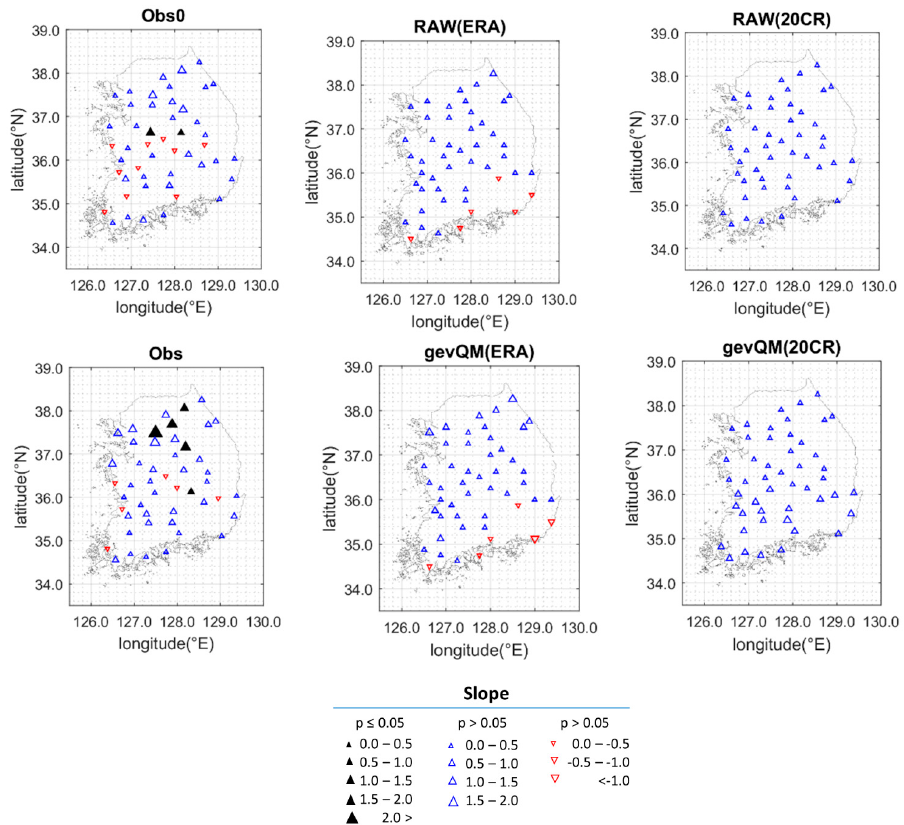
Figure 7. Trends in the AMRs of the observation for 1974–2017(Obs0) and 1974–2010(Obs), respectively, and the AMRs of the raw reanalyses (RAW) and the bias ‐ corrected values by the QM approach (gevQM) for the reference period (1974–2010). ERA and 20CR mean the data from the ERA ‐ 20c and 20CR in this figure. Note that solid triangles represent signifi ‐ cant trends at the 95% confidence levels, while hollow triangles mean no significant trends. The upward ‐ pointing triangle and downward ‐ pointing indicate increasing slope and decreasing slope, respectively, whereas the size of triangle repre ‐ sents the magnitude of trends. To estimate nonstationarity over the 20th century, we also checked a century ‐ long trend using the bias corrected AMRs of ERA ‐ 20c and 20CR from 1900 to 2010, instead of the observation periods Obs and Obs0. Figure 8 illustrates the trend test results for the AMRs of the bias corrected reanalyses in 48 stations from 1900 to 2010. For ERA ‐ 20c, the corrected values by SQM approaches (gevSQM, gamSQM and gumSQM) had obvious increasing trends in all stations, and the QDM algorithms (gevQDM, gamQDM and gumQDM) also indicated the significant increasing trends at 0.05 significance level, except a few points. The results for 20CR were similar to those for ERA ‐ 20c. The bias ‐ corrected values demonstrated the obvious increasing trends for both SQM and QDM schemes of the whole 20th century. These results imply that the AMRs in South Korea may have an increasing trend over the 20th century, although the AMRs in recent decades are not able to clarify the nonstationary characteristic.